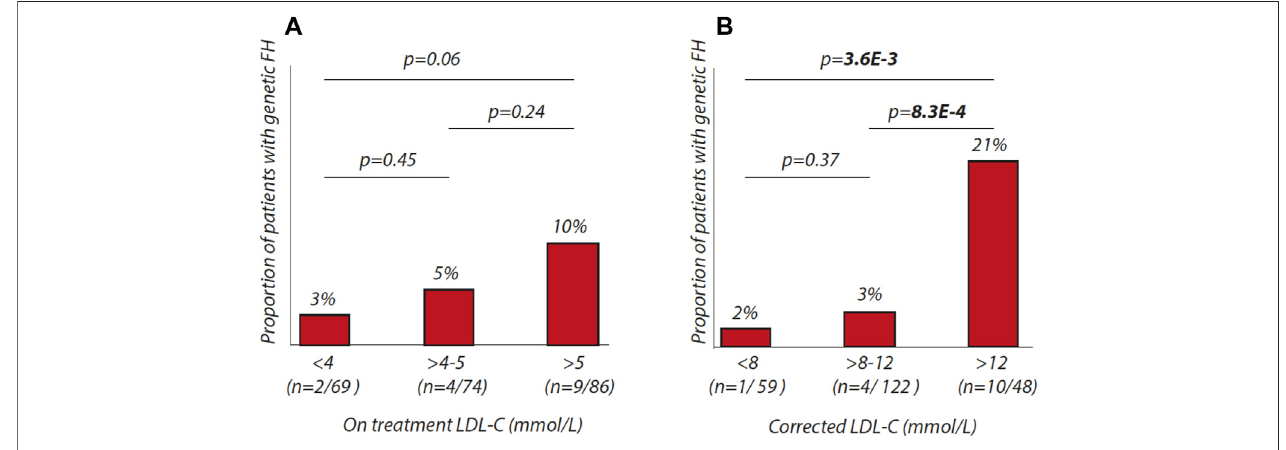
FIGURE 1 | Percentages of patients withgeneticFH in different LDL-C ranges. (A) proportion of patients with geneticFH accordingto on-treatment LDL-C ranges ( < 4 mmol/L, > 4to5 mmol/L, > 5 mmol/L). (B) proportionofpatientswithgeneticFHaccordingtocorrected-LDL-Cranges( < 8 mmol/L, > 8to12 mmol/L, > 12